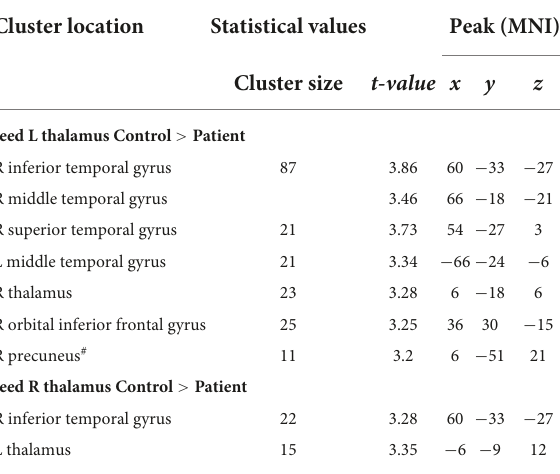
thalamus seed and regions of bilateral IFG, right middle frontal gyrus (MFG), right angular gyrus, right inferior parietal lobule (IPL), right fusiform, right ITG, right cerebellum, left precentral gyrus, left supplementary motor area (SMA), left superior parietal lobule (SPL), left precuneus, and left paracentral gyrus ( Figure 2A ). Compared with the HCs, the patient group exhibited significant less dFC variability between the right thalamus seed and regions of bilateral MFG, bilateral IPL, right superior frontal gyrus (SFG), right angular gyrus, right SMA, right SPL, right fusiform, right ITG, right MTG, right cerebellum, left precuneus, and left paracentral gyrus ( Figure 2B ). No significant excessive dFC variability was found in the patient group with the bilateral thalamus seeds.